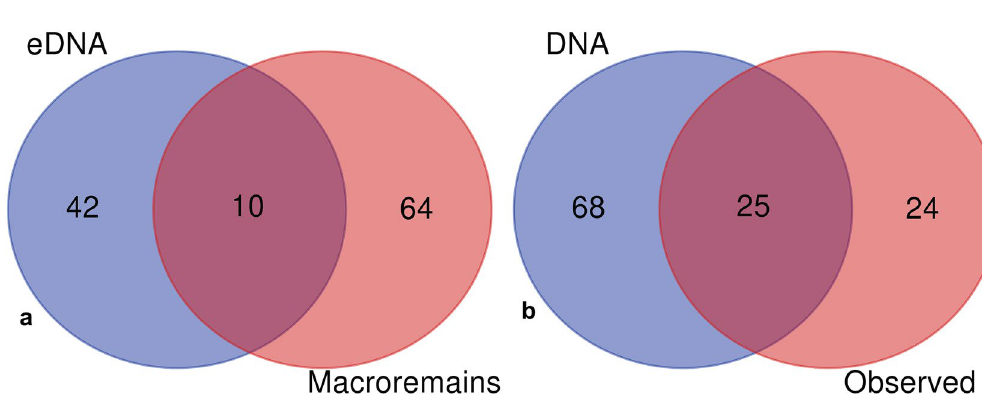
Figure 3. Diagrams showing: ( a ) the overlap in archeological plants identified at Tikal using eDNA technologies compared to conventional paleoethnobotanical analyses of plant macroremains and pollen and ( b ) the overlap between the results of soil DNA analyzed from a household garden in the village of Uaxactun, Guatemala, as compared to plants actually observed in the garden. David Lentz created the final figure using Photoshop CS6, Vers. 13.0.1 × 64 (https:// www. adobe. com/ produ cts/ photo shop/ prici ng- info.